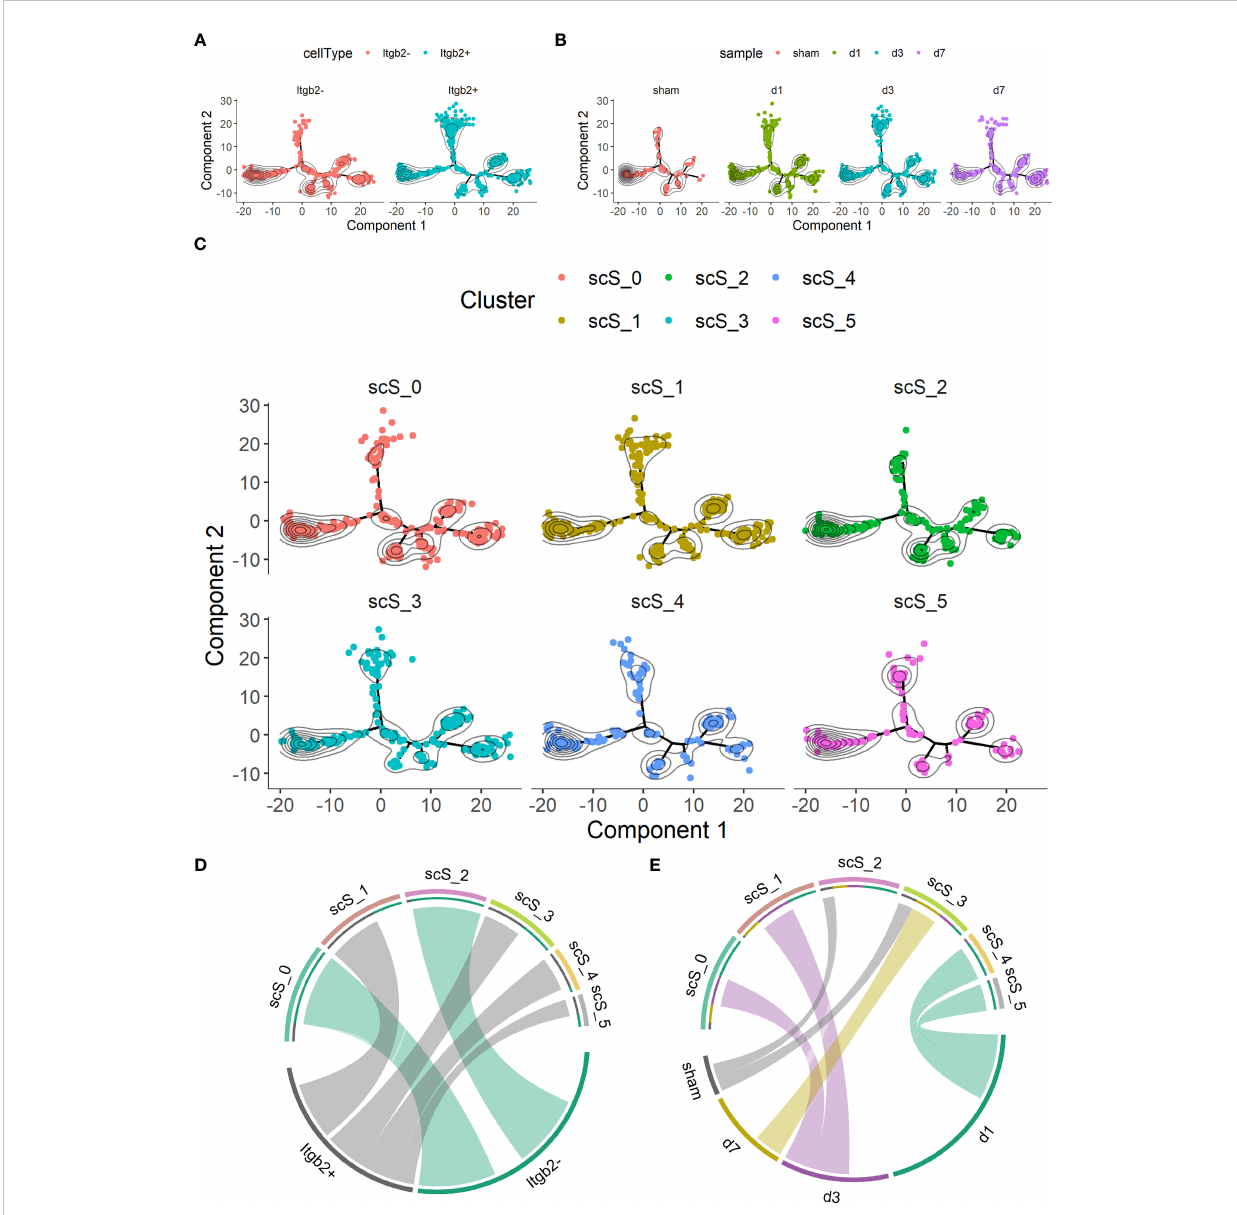
FIGURE 3 scSTAR of itgb2 + microglia subclusters in groups on day 1, 3 and 7 after tMCAO (A) Trajectory analysis of the Itgb2 + microglia subcluster by scSTAR. (B) The distribution of cells at time points on trajectory by scSTAR. (C) The trajectory of 6 microglia subclusters by scSTAR. (D) The relationship with Itgb2 expression pattern and subclusters by scSTAR after tMCAO via chord-charts. (E) The relationship with Itgb2 expression pattern and time points after tMCAO via